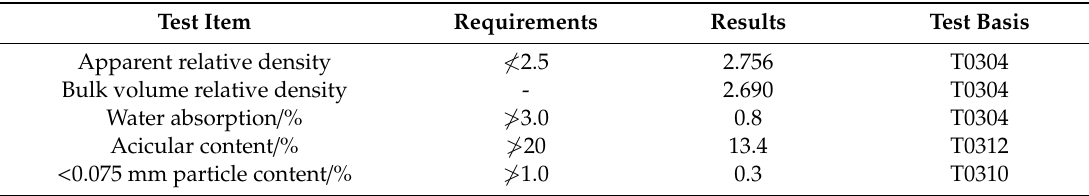
Table 5. Physical properties of quartzite.